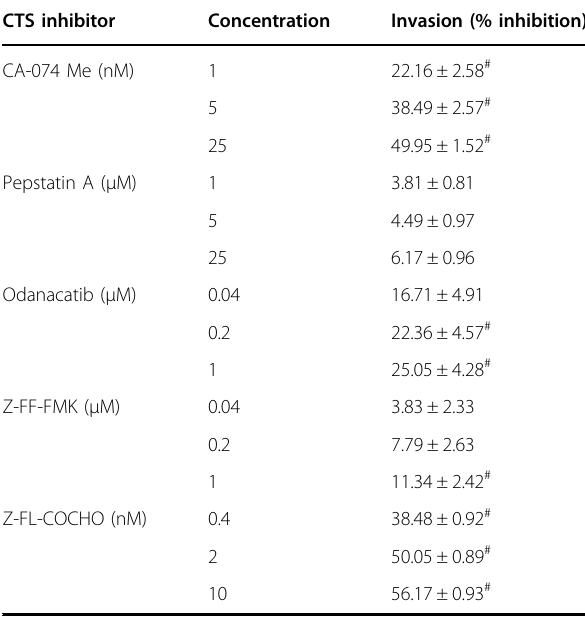
Table 2 The effects of CTS inhibitors on the viability and serum-induced invasion of MDA-MB-231 cells CTS